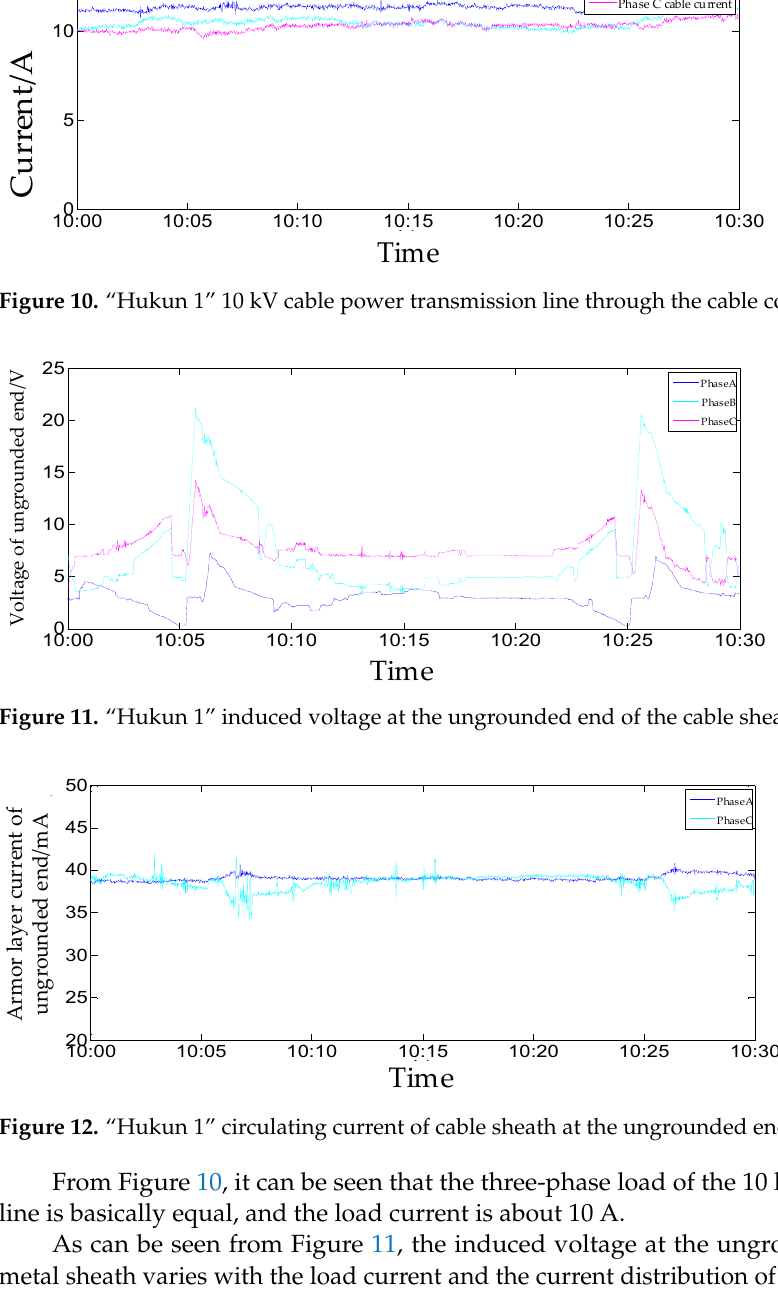
Figure 12. “Hukun 1” circulating current of cable sheath at the ungrounded end.